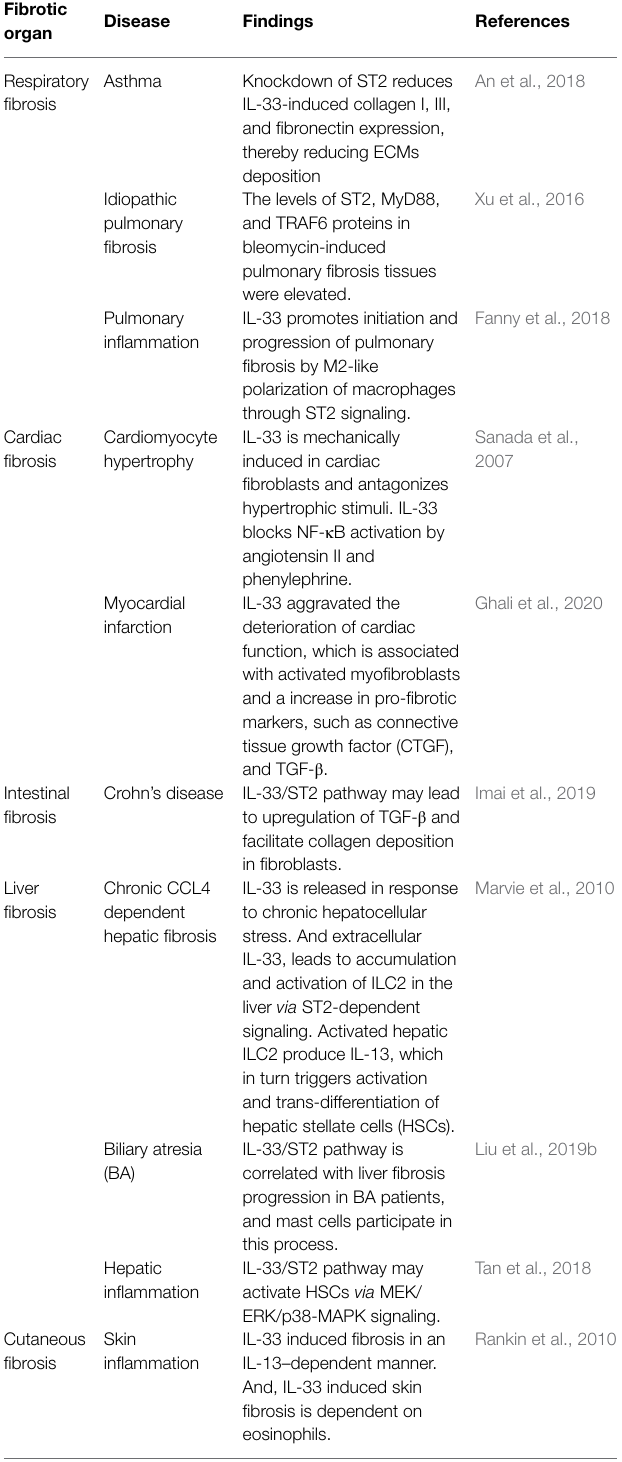
TABLE 1 | The role of IL-33/ST2 in fibrosis of various